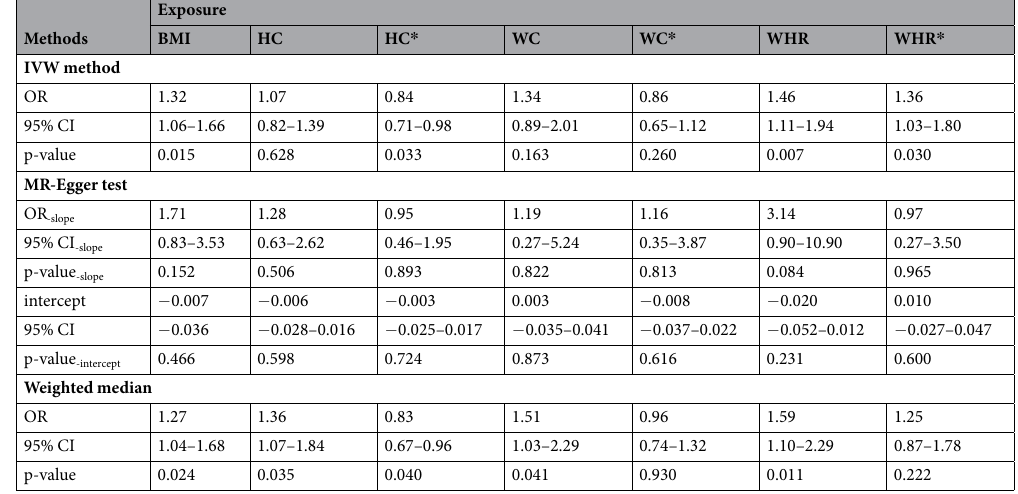
Table 2. Causal estimates of the association of obesity-related traits on risk of CAD, excluding overlap SNPs. * Indicates that this trait was adjusted for body mass index (BMI) in our study. R 2 refers to the proportion of variance of the exposure explained by the instruments. Hip circumference (HC), waist circumference (WC), waist-hip ratio (WHR), odds ratio (OR), confidence interval (CI), instrumental variable (IV), inverse variance weighted (IVW). In the table, the standard deviations (SDs) for BMI, HC, WC and WHR are 4.770 (kg/m 2 ), 8.455 (cm), 12.520 (cm) and 0.074, respectively. OR means that the change in odds in CAD with a 1-SD increase in each obesity-related trait. P-heterogeneity is derived from the Q statistic, and p-intercept is derived from the MR-Egger